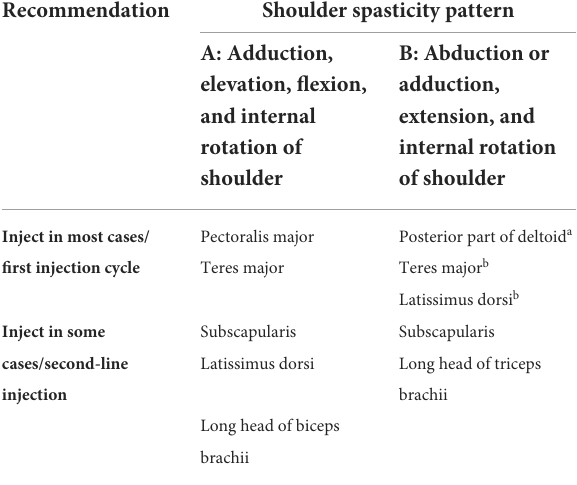
TABLE 1 Relationship of shoulder muscles with upper limb spasticity patterns for identifying candidate shoulder muscles for BoNT-A